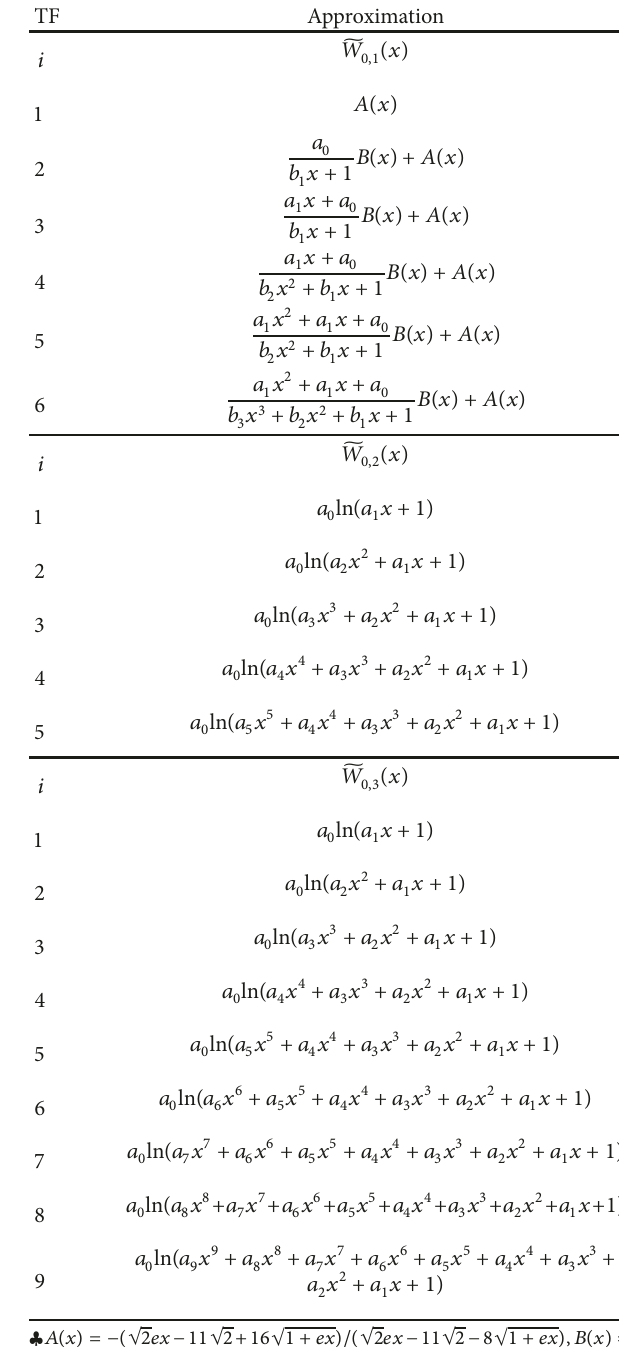
Table 2: Trial ( 𝑖 -th) functions (TF) for PSEM for ̃𝑊 (𝑥) and 0,3